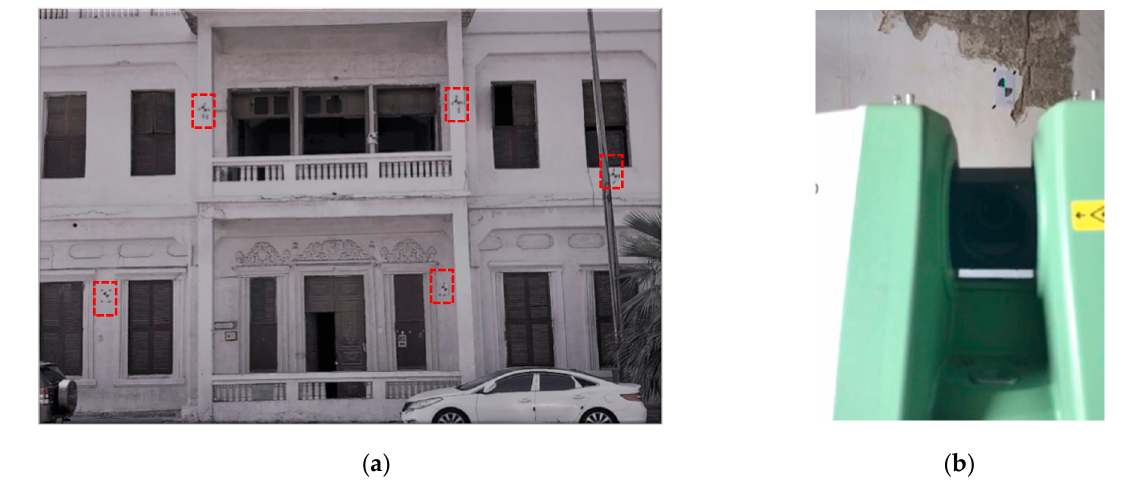
Figure 9. Utilizing the B/W targets on the façades ( a ) and identifying the target ( b ).